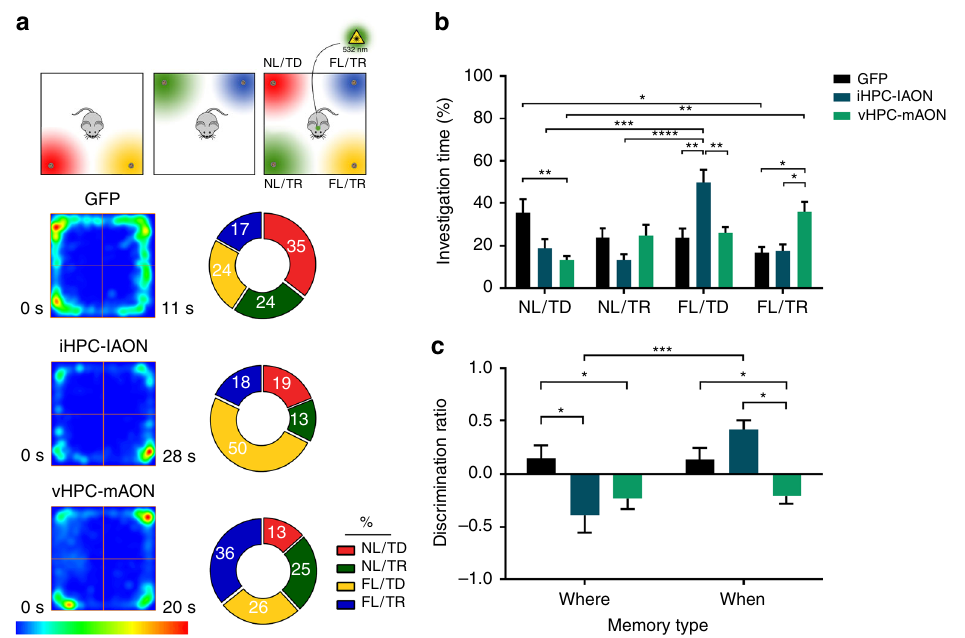
Fig. 3 HPC-AON pathways contribute distinct spatiotemporal information during episodic odour recall. a Top: illustration of the episodic memory test paradigm. Bottom: heat maps depicting group average position (left) and pie charts representing the percent investigation time (right) during the retrieval phase of the episodic memory test (all groups: n = 12). b Comparison of percent investigation time for all groups during the retrieval phase of the episodic memory test (two-way ANOVA, treatment-by-odour interaction F (6,132) = 9.532, **** P < 0.0001, main effect of odour F (3,132) = 5.415, ** P < 0.005). c iHPC- lAON pathway inhibition impaired the spatial, but not temporal component of odour memory, while vHPC-mAON pathway inhibition impaired both components to a similar extent (two-way ANOVA treatment-by-memory type interaction F (2,66) = 9.320, *** P < 0.0005; main effect of treatment F (2,66) = 6.715, ** P < 0.005; main effect of memory type F (1,66) = 9.620, ** P < 0.005). FL/TD, familiar location/temporally distant; FL/TR, familiar location/ temporally recent; NL/TD, novel location/temporally distant; NL/TR, novel location/temporally recent. Data are presented as mean ±